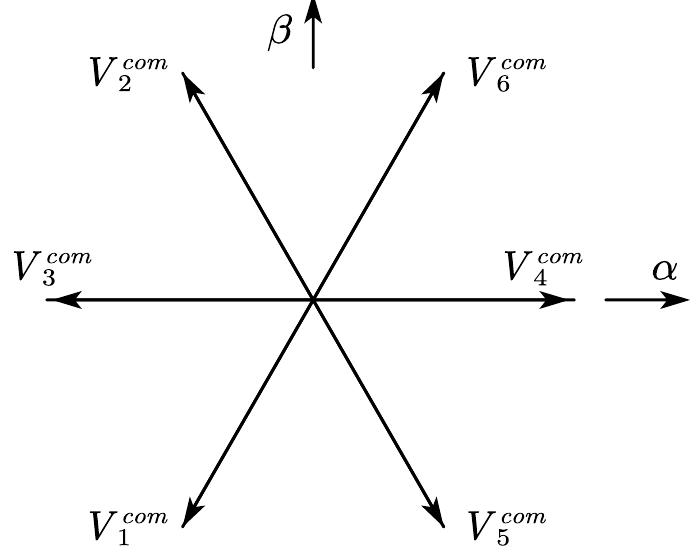
Figure 8. Compensation voltage vectors for dead-time effect.